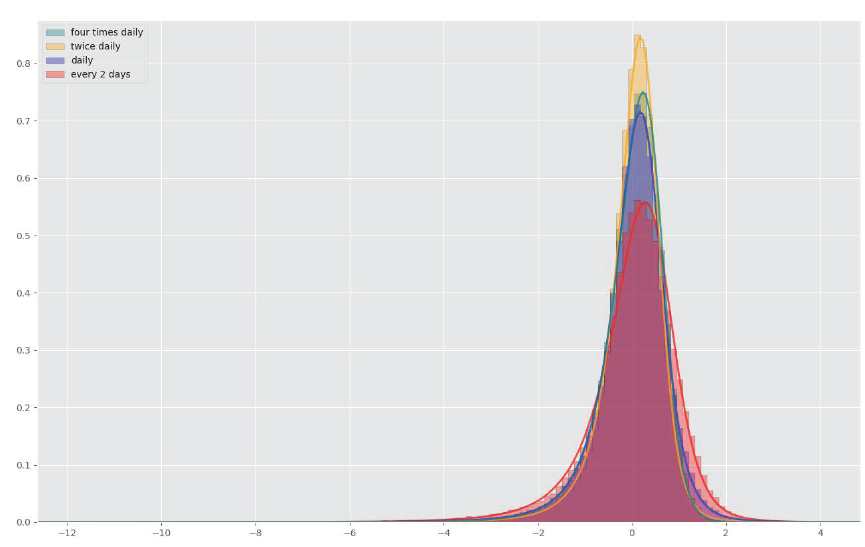
Figure 7. fRNN deep hedge for different hedging frequencies (with H = 0.10). The plot was rescaled, because of the massive outliers in the two day rehedge case. Non-central t distribution was fit for better visiblity. Table 4. Comparison of the fRNN deep hedge quadratic losses for different hedging frequencies (with H = 0.10). Rehedging Frequency H =